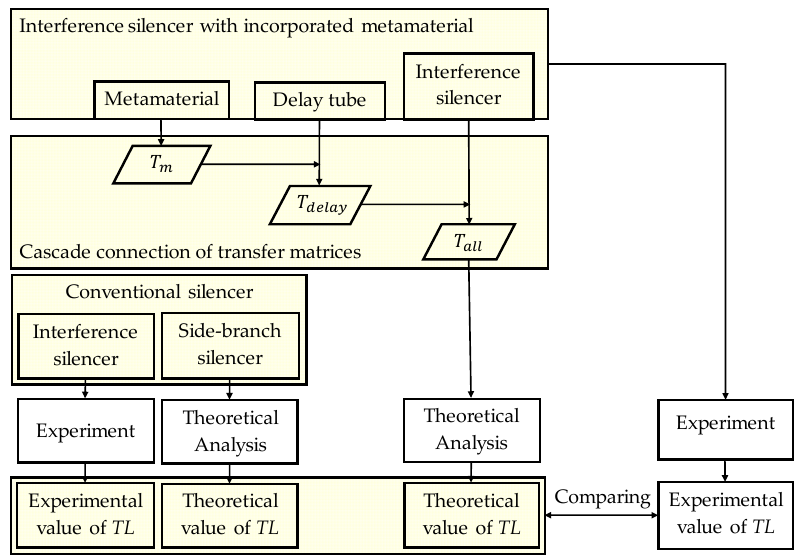
Figure 3. Flowchart of experimental and theoretical analysis process.